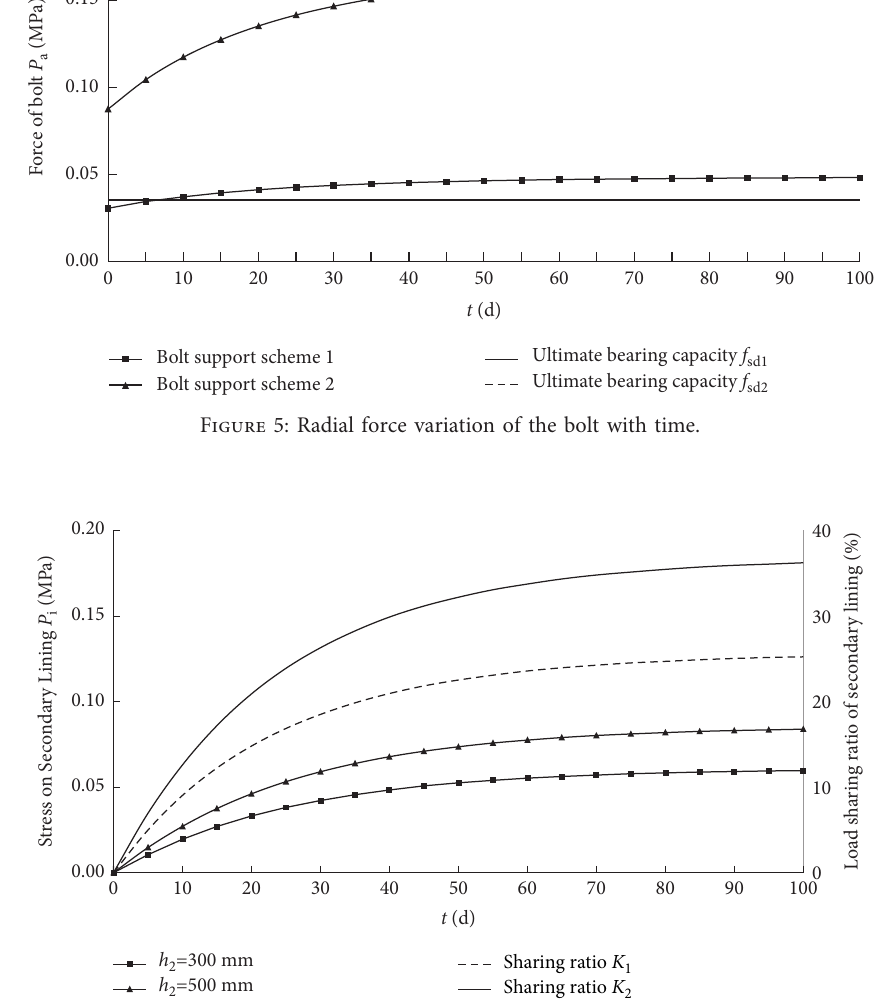
Figure 6: Variation of radial force with time under different thicknesses of the secondary